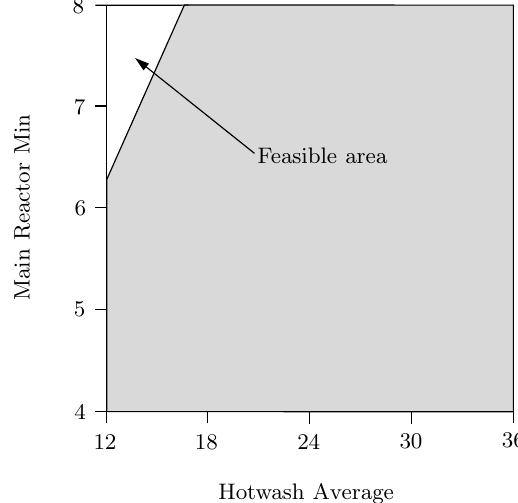
Figure 8: The feasible area for percentage time offline between 0 and 1%, and availability between 90 and